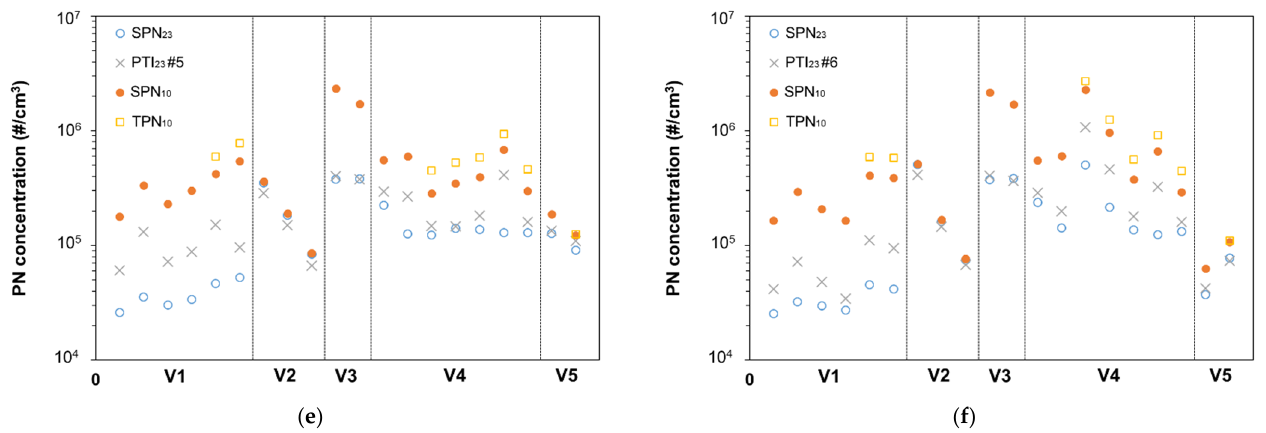
Figure 5. Summary of PTI sensors measurements and comparison with SPN 23 measured with a PMP compliant system. SPN 10 and TPN 10 (when available) are also provided. ( a ) PTI #1; ( b ) PTI #2; ( c ) PTI #3; ( d ) PTI #4; ( e ) PTI #5; ( f ) PTI #6.